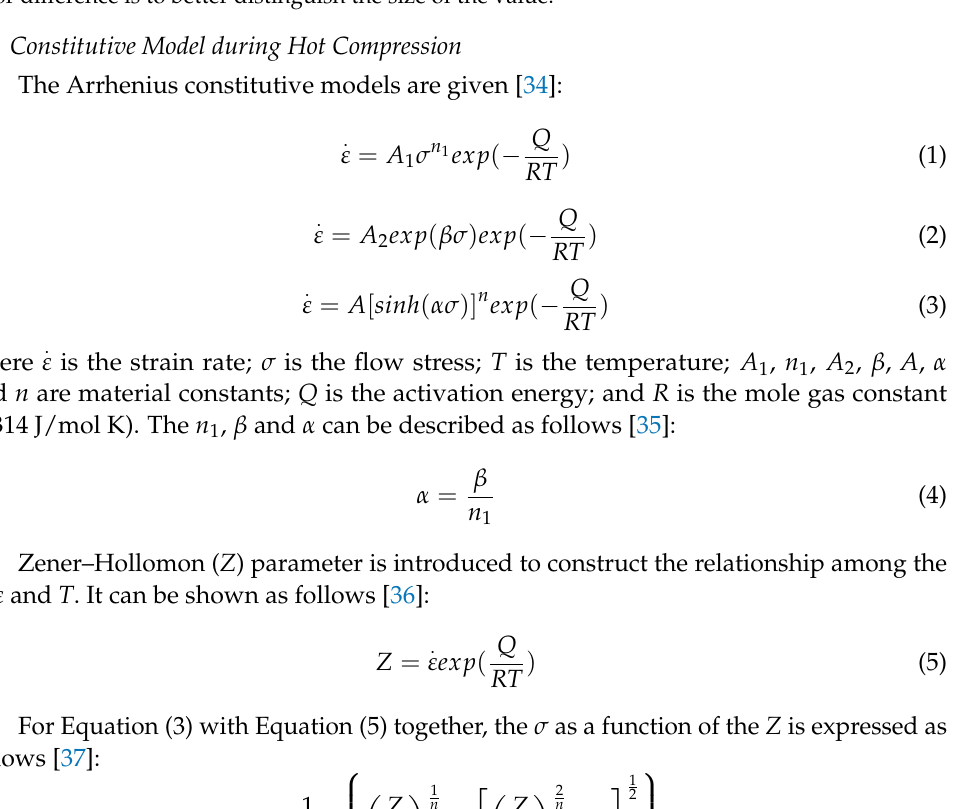
Figure 4. ( a ) Peak stresses and ( b ) peak strains at different deformation conditions. Note that the color difference is to better distinguish the size of the value.